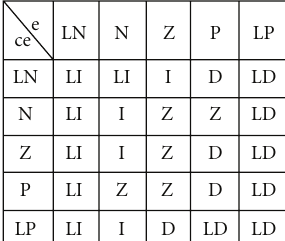
modified by the application of the STA algorithm and their e ff ect in the system